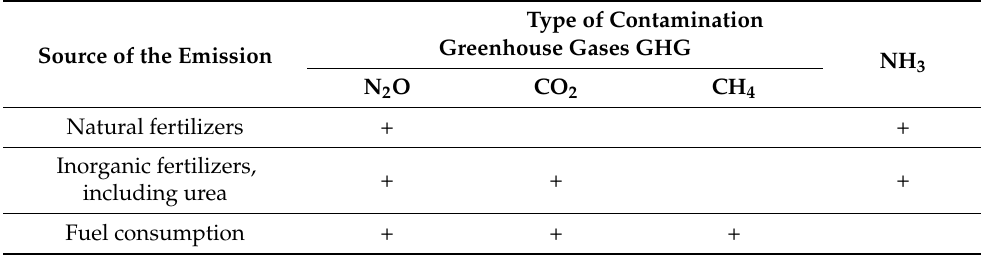
Table 1. Sources of emissions and types of pollutants emitted to the atmosphere.